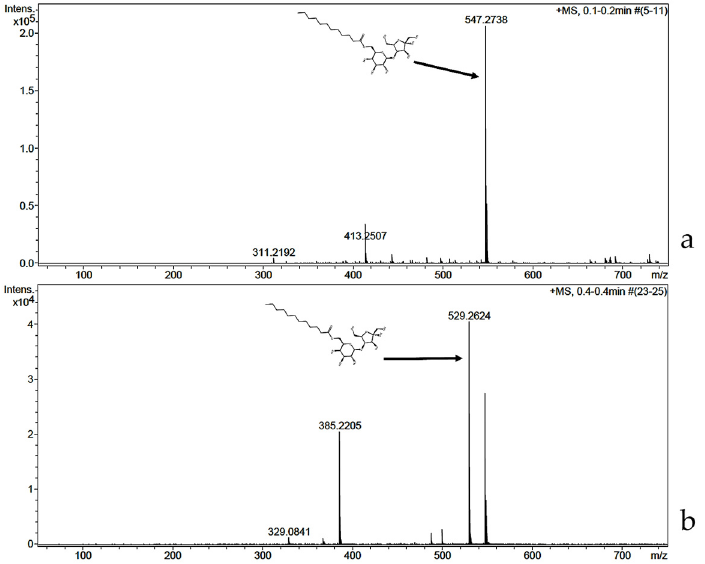
Figure 6. MS-ESI (+) spectra from the purified reaction products: ( a ) Monoester fraction 1 of Novozym 435; ( b ) Monoester fraction 2 of Lipozyme TL IM.